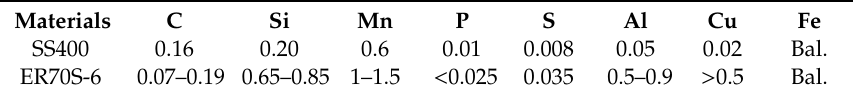
Figure 1. Experimental set-up for various welding positions.